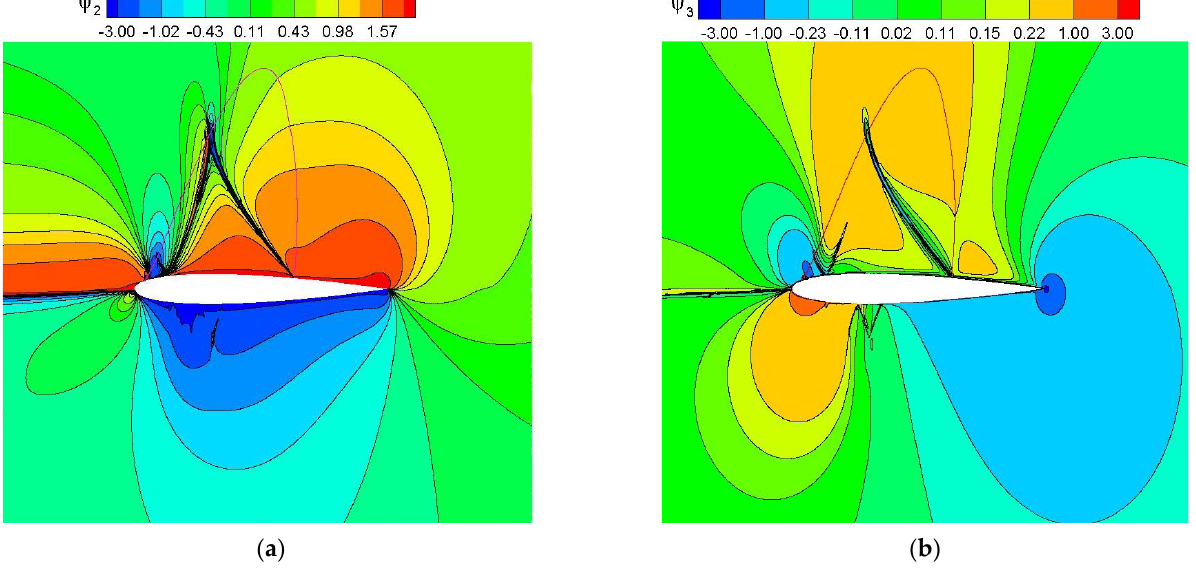
Figure 11. Flow past a NACA0012 airfoil at M = 0.8 and α = 1.25°. Contour lines for the x − momentum variable ψ 2 ( a ) and y − momentum variable ψ 3 ( b ). The shock position is indicated for reference.